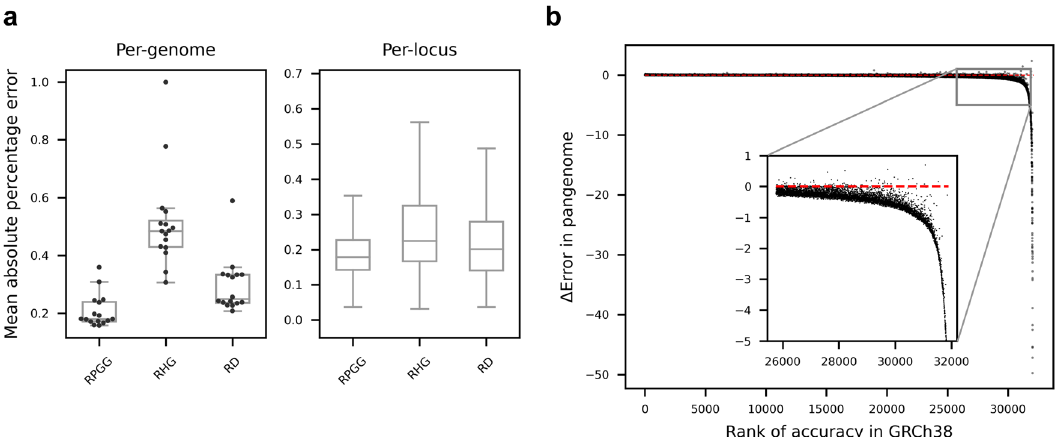
Fig. 3 VNTR length prediction. a Accuracies of VNTR length-prediction measured for each genome (left; n = 16) and each locus (right; n = 32,138). Mean absolute percentage error (MAPE) in VNTR length is averaged across loci and genomes, respectively. Lengths were predicted based on repeat-pangenome graphs (RPGG), repeat-GRCh38 (RHG) or naive read depth method (RD), respectively. Boxes span from the lower quartile to the upper quartile, with horizontal lines indicating the median. Whiskers extend to points that are within 1.5 interquartile range (IQR) from the upper or the lower quartiles. b Relative performance of RPGG versus repeat-GRCh38. Loci are ordered along the x -axis by genotyping accuracy in repeat-GRCh38. The y -axis shows the decrease in MAPE using RPGG versus repeat-GRCh38. The subplot shows loci poorly genotyped (MAPE > 0.4) in repeat-GRCh38. The red dotted line indicates the baseline without any improvement. the counts from reads mapped to the RPGG (red) and repeat-GRCh38 (blue), respectively. Source data are provided as a Source Data fi